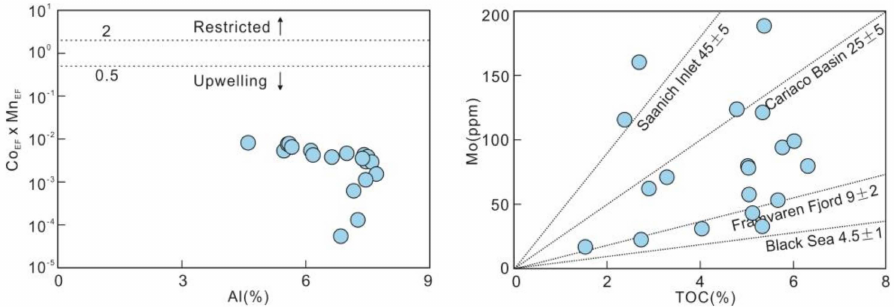
Figure 10. Crossplot of Co EF × Mn EF vs. Al showing upwelling influence for the Meizwan sediments, and the dashed lines are adopted from Sweere et al. [95]. Crossplot of TOC vs. Mo indicating generally good connection between Meiziwan and the open ocean, and the trend lines are modified from Algeo and Lyons